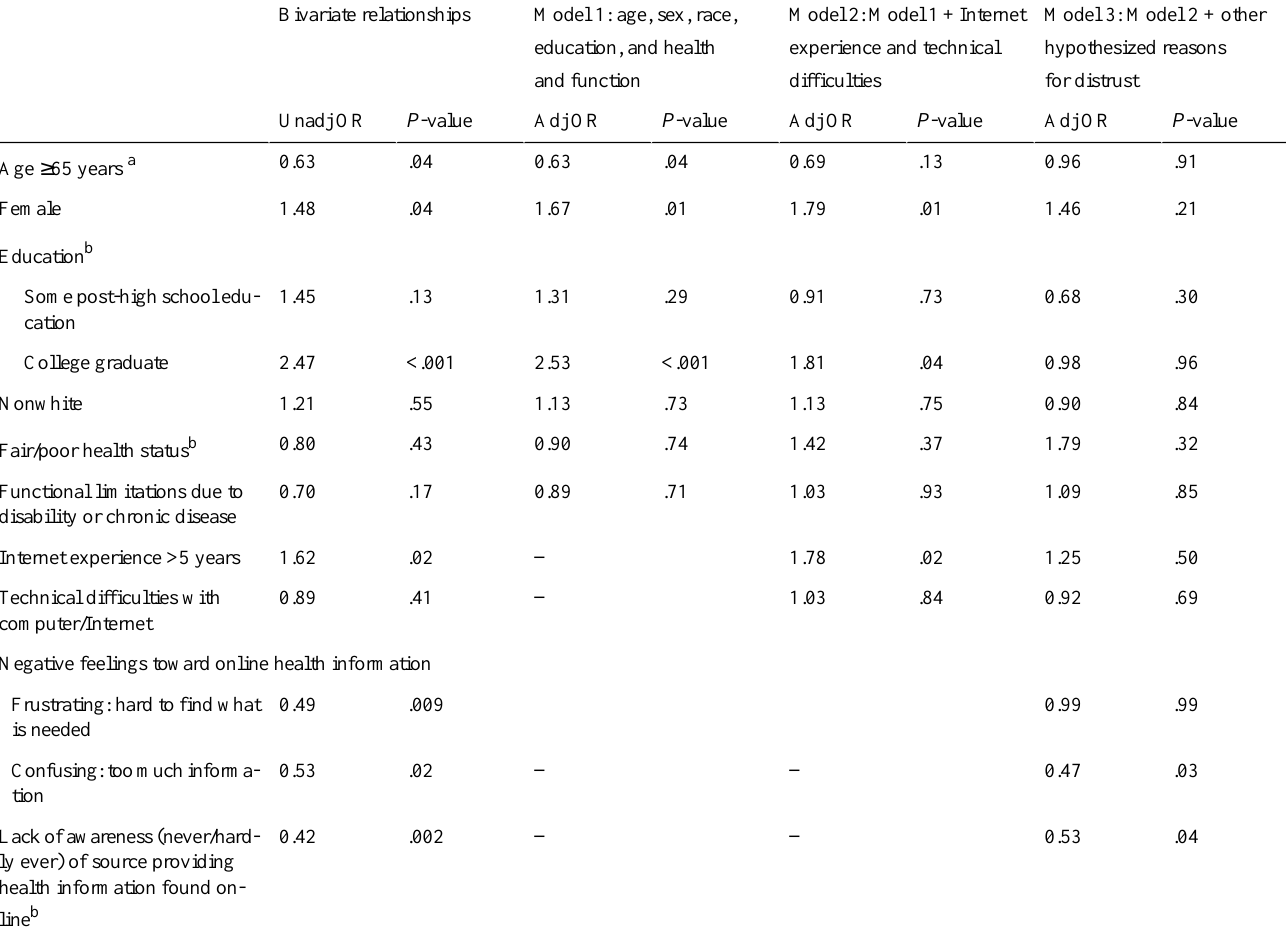
Table 3. Characteristics associated with trust in the Internet as a source of health information among adults ≥ 50 years of age who use the Internet (n =